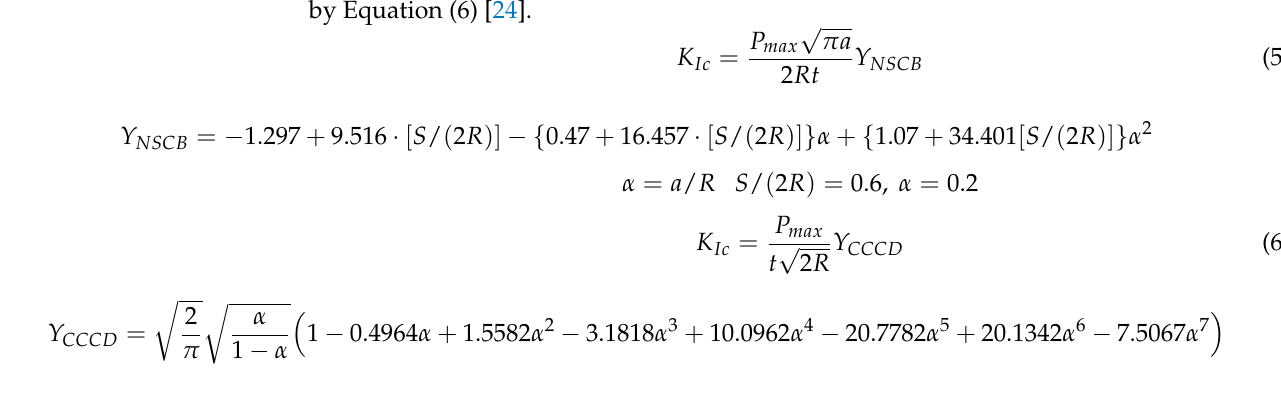
Table 3. Peak load, P max , and fracture toughness, K Ic , of all